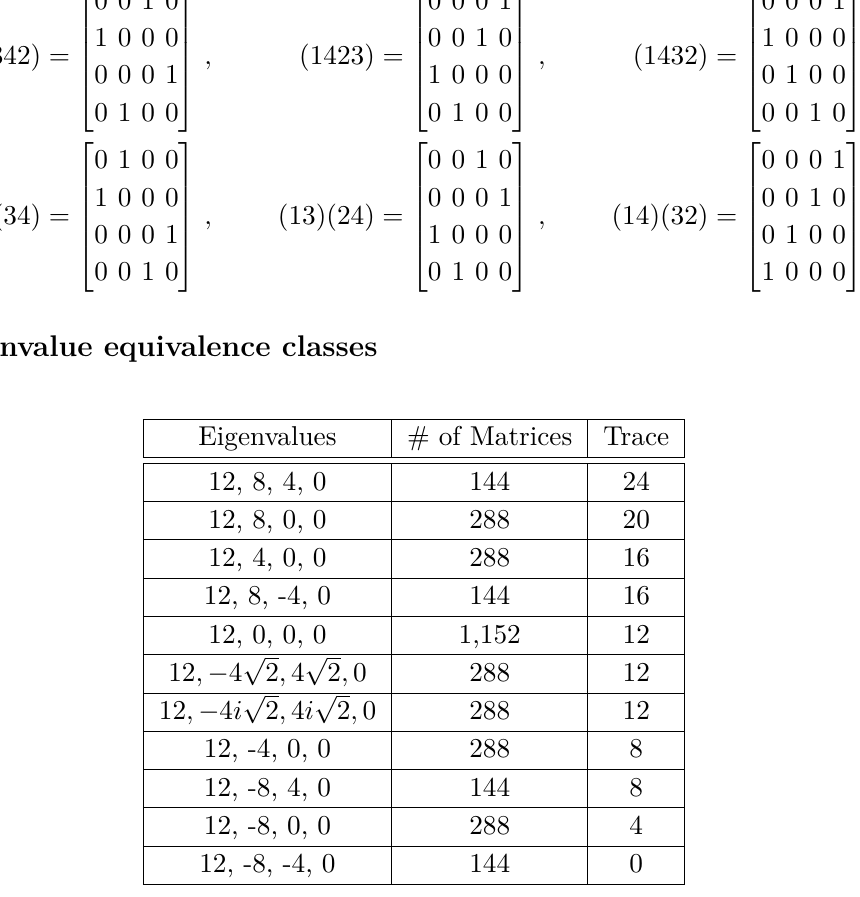
Table 24 . Eigenvalue equivalent classes of 3,456 distance matrices in class (1).